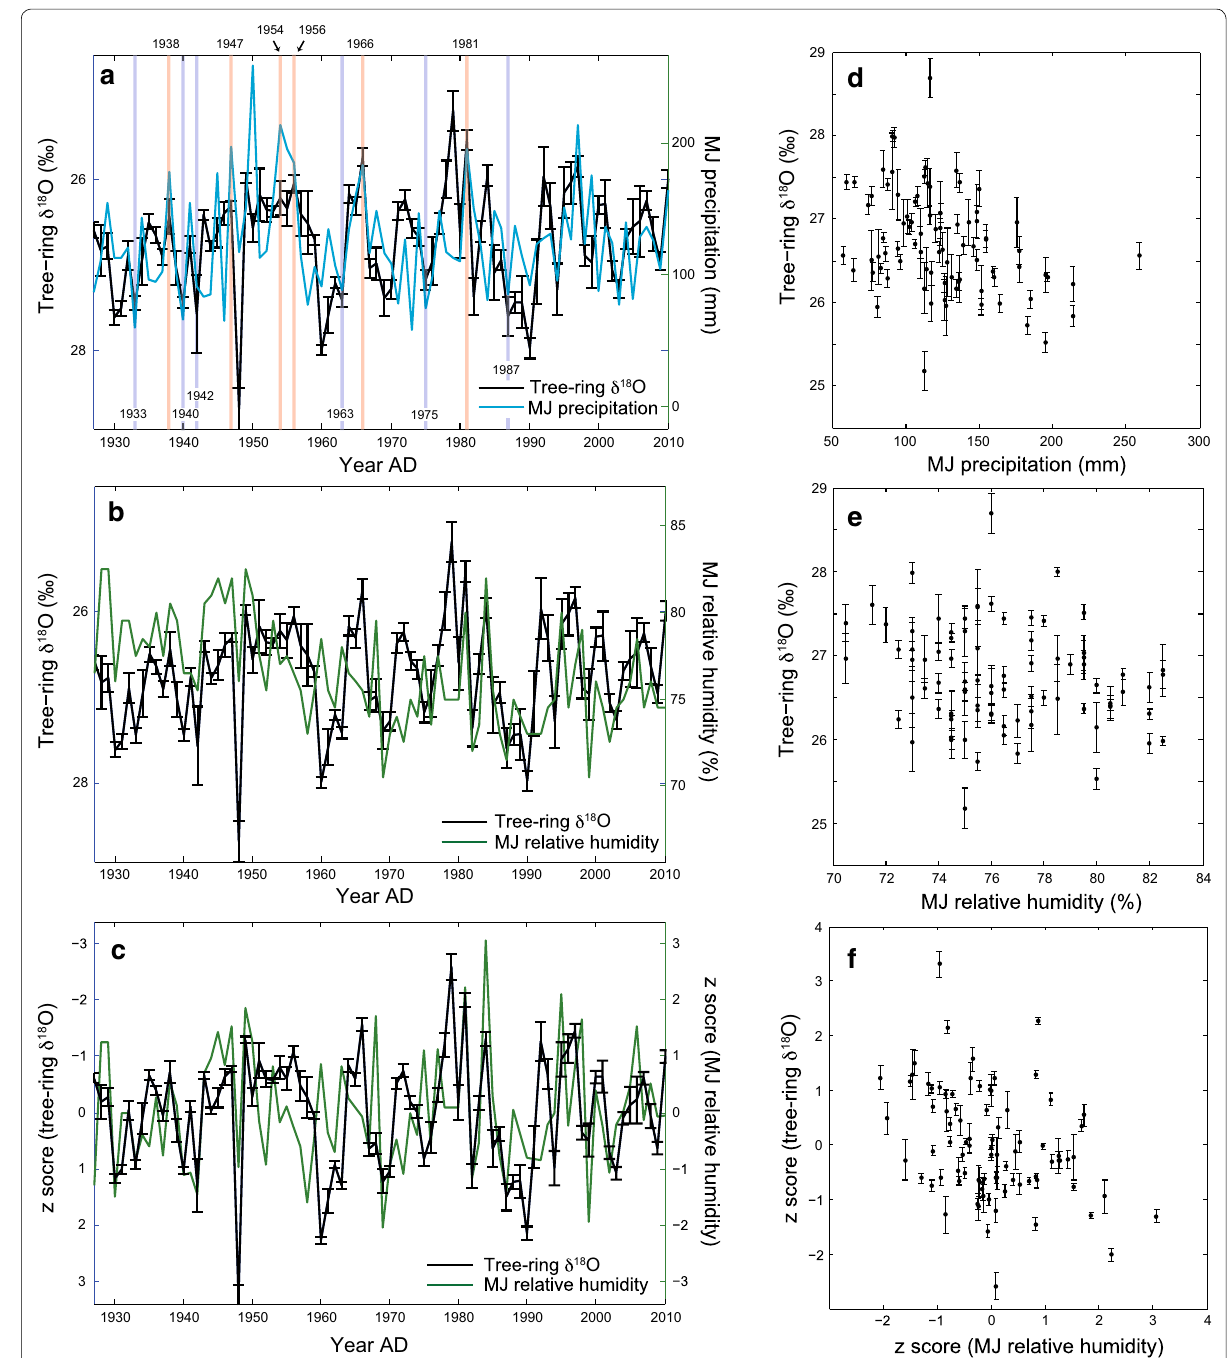
Fig. 3 Temporal comparisons between tree-ring δ 18 O and a MJ precipitation, and b MJ relative humidity in Sendai station from A.D. 1927 to 2010. c Tree-ring δ 18 O and MJ relative humidity after removal of low-frequency component. Black, blue, and green solid lines indicate tree-ring δ 18 O, MJ precipitation, and MJ relative humidity, respectively. Z -score is zero mean and unit standard deviation. Scatter plot of tree-ring δ 18 O versus d MJ precipitation, and e MJ relative humidity. f Scatter plot of tree-ring δ 18 O versus MJ relative humidity after removal of low-frequency